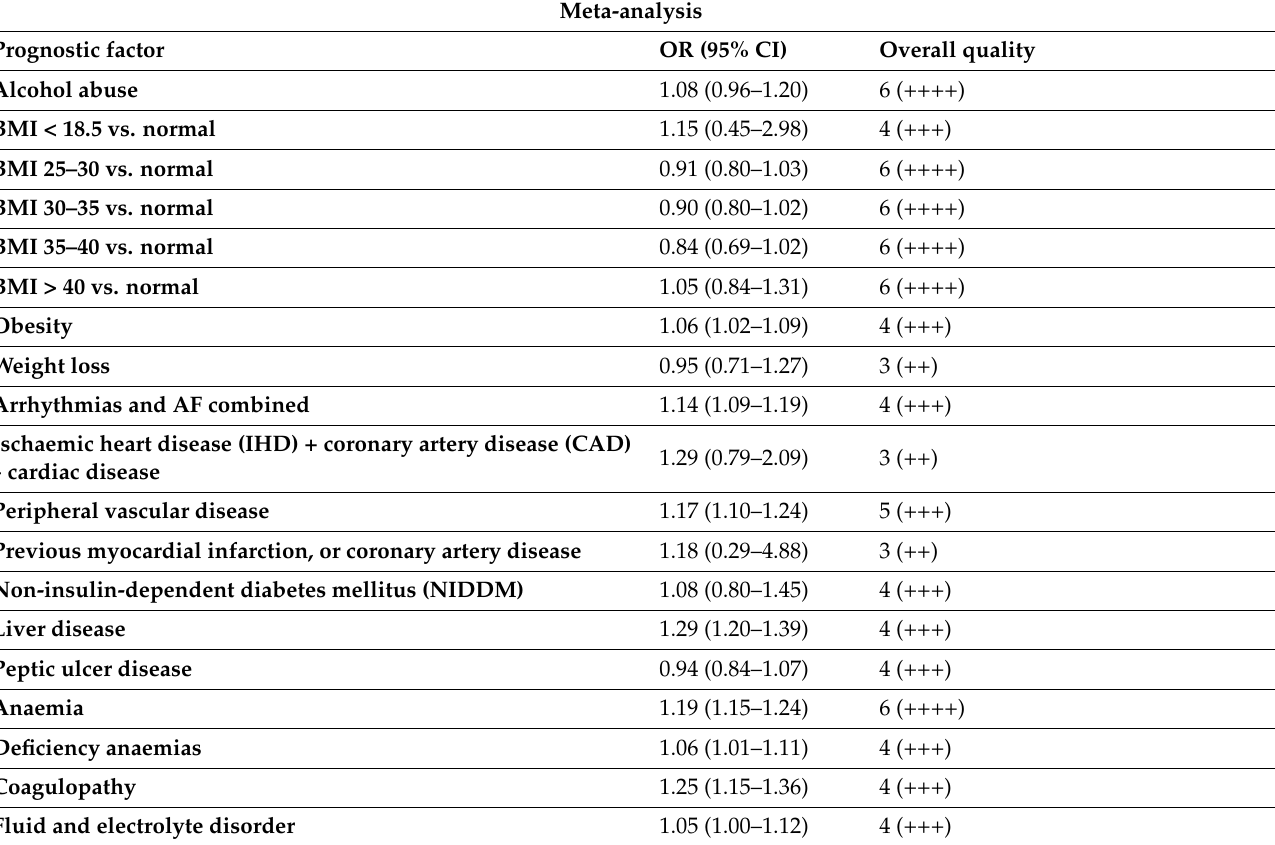
Table 4. Summary of